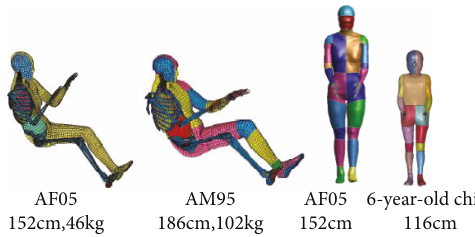
Figure 2: THUMS models [53].